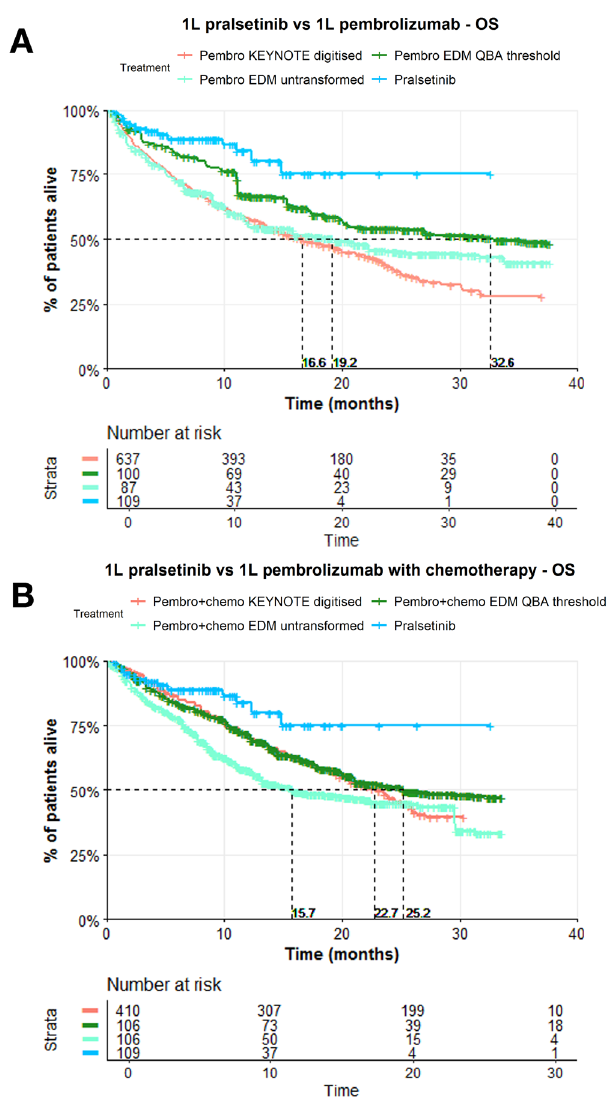
Fig. 3 Kaplan – Meier curves for OS showing the robustness of the estimated hazard ratios for the comparison between 1 L pralsetinib trial cohort and 1 L pembrolizumab cohort, and 1 L pralsetinib trial cohort and 1 L pembrolizumab with chemotherapy cohort when the RWD cohorts are transformed to have increased OS. A The Kaplan – Meier curves for OS correspond to the comparison between 1 L pralsetinib versus 1 L pembrolizumab ( N = 637 for the digitised KEYNOTE cohort, ESS = 109 for the pralsetinib cohort, ESS = 115 for the pembrolizumab cohort when untransformed and at the transformation threshold), and B corresponds to the comparison between 1 L pralsetinib versus 1 L pembrolizumab with chemotherapy ( N = 410 for the digitised KEYNOTE cohort, ESS = 109 for the pralsetinib cohort, ESS = 217 for the pembrolizumab with chemotherapy cohort when untransformed and at the transformation threshold) after QBA of the HRs; red indicates the digitised curve from the corresponding KEYNOTE trial (KEYNOTE-42 for pembrolizumab and KEYNOTE-189 for pembrolizumab with chemotherapy), light green indicates the untransformed weighted KM curve for the EDM cohort, dark green is the weighted KM curve for the EDM at the transformation threshold where the adjusted HR remains signi fi cant, and blue indicates the pralsetinib group ’ s weighted KM